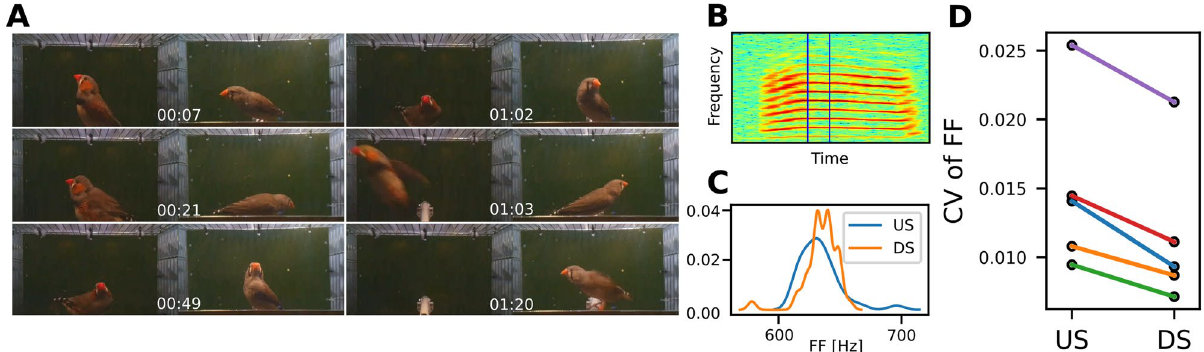
Figure 3. Adult male zebra finches sing directed song to their mate through the virtual environment. ( A ) Male (left) and female (right) displaying behaviours associated with directed song. ( B ) Spectrogram of a syllable with harmonic stack used to estimate fundamental frequency. The vertical lines indicate the part of the syllable used to estimate fundamental frequency. ( C ) Kernel density estimates for the fundamental frequency of the syllable above based on 30 renditions with the system on (DS) and 30 with the system off (US). ( D ) The Coefficient of Variance of the fundamental frequency is significantly lower when the virtual environment is on